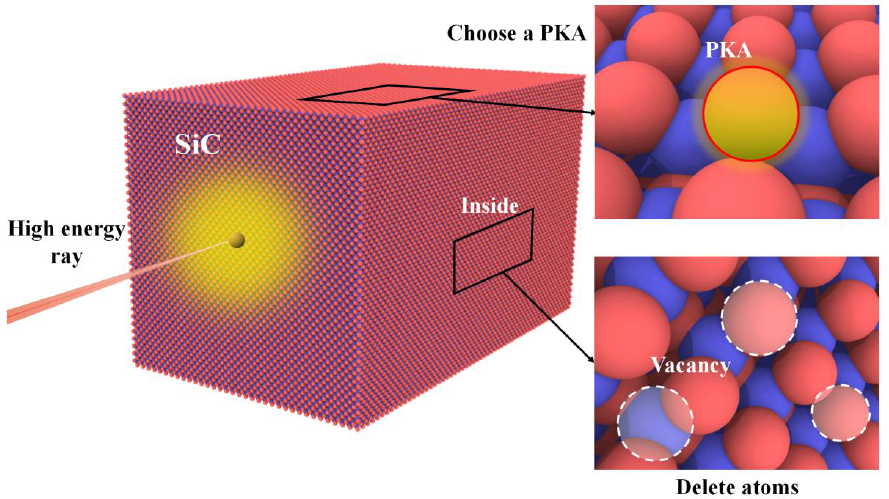
Figure 12. Three typical irradiation damage simulation models of SiC [82].